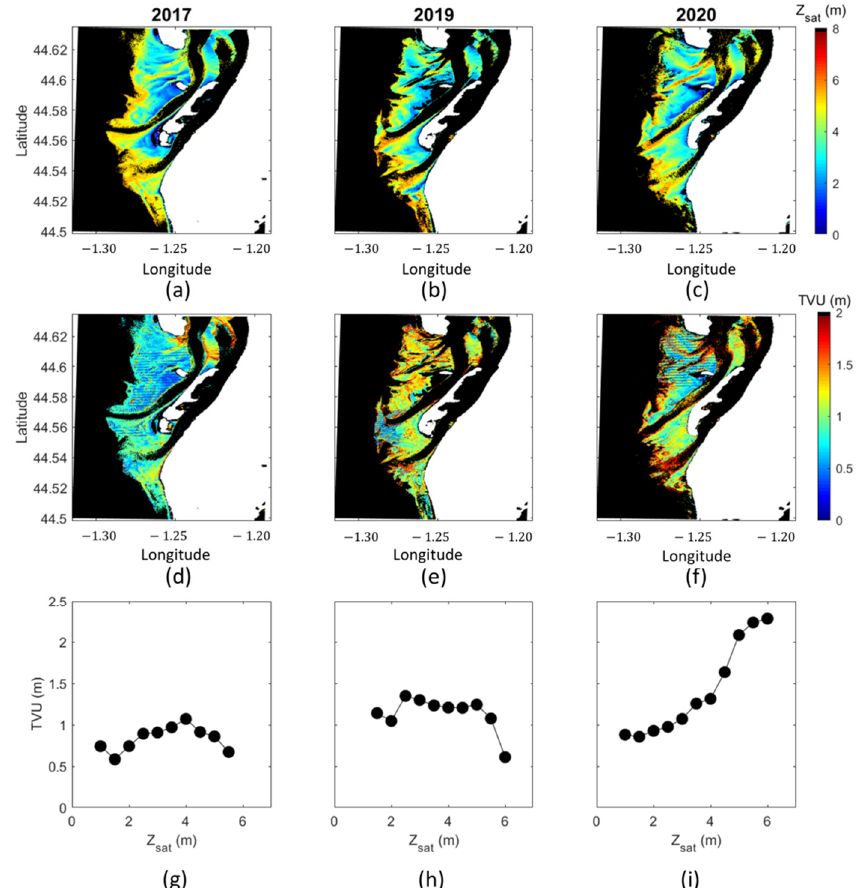
Figure 10. ( a – c ) SDB maps, ( d – f ) total vertical uncertainty ( TVU ) maps, and ( g – i ) TVU averaged per bins for 2017 (6 images), 2019 (5 images), and 2020 (4 images), computed from a multi-scene ap- proach.